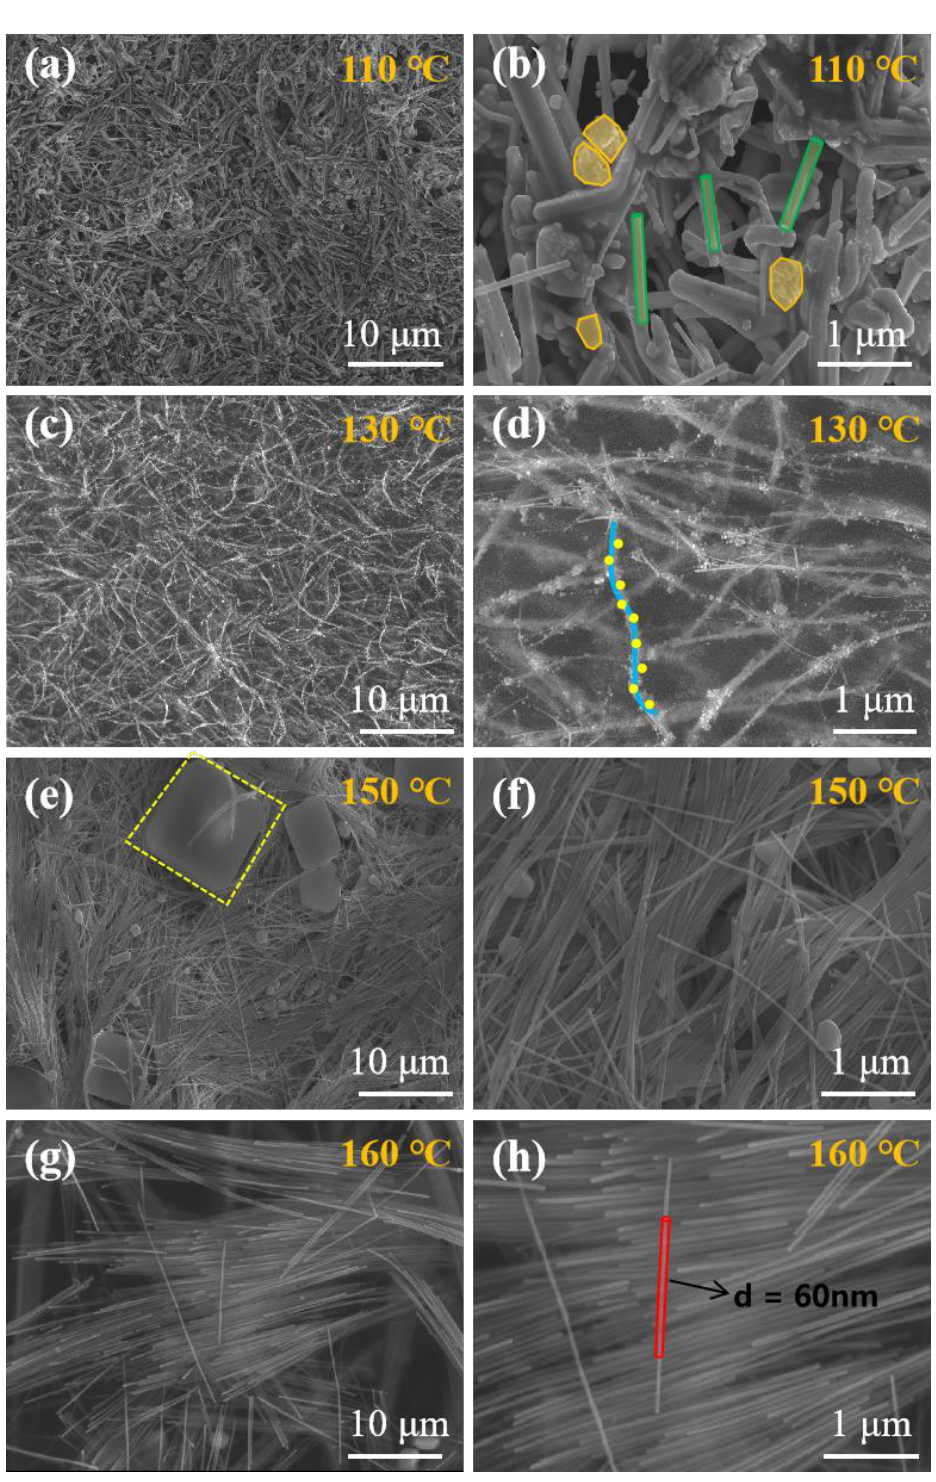
Figure 6. SEM images of AgNWs prepared at different temperatures: ( a , b ) 110 °C; ( c , d ) 130 °C; ( e , f ) 150 °C; ( g , h )160 °C.